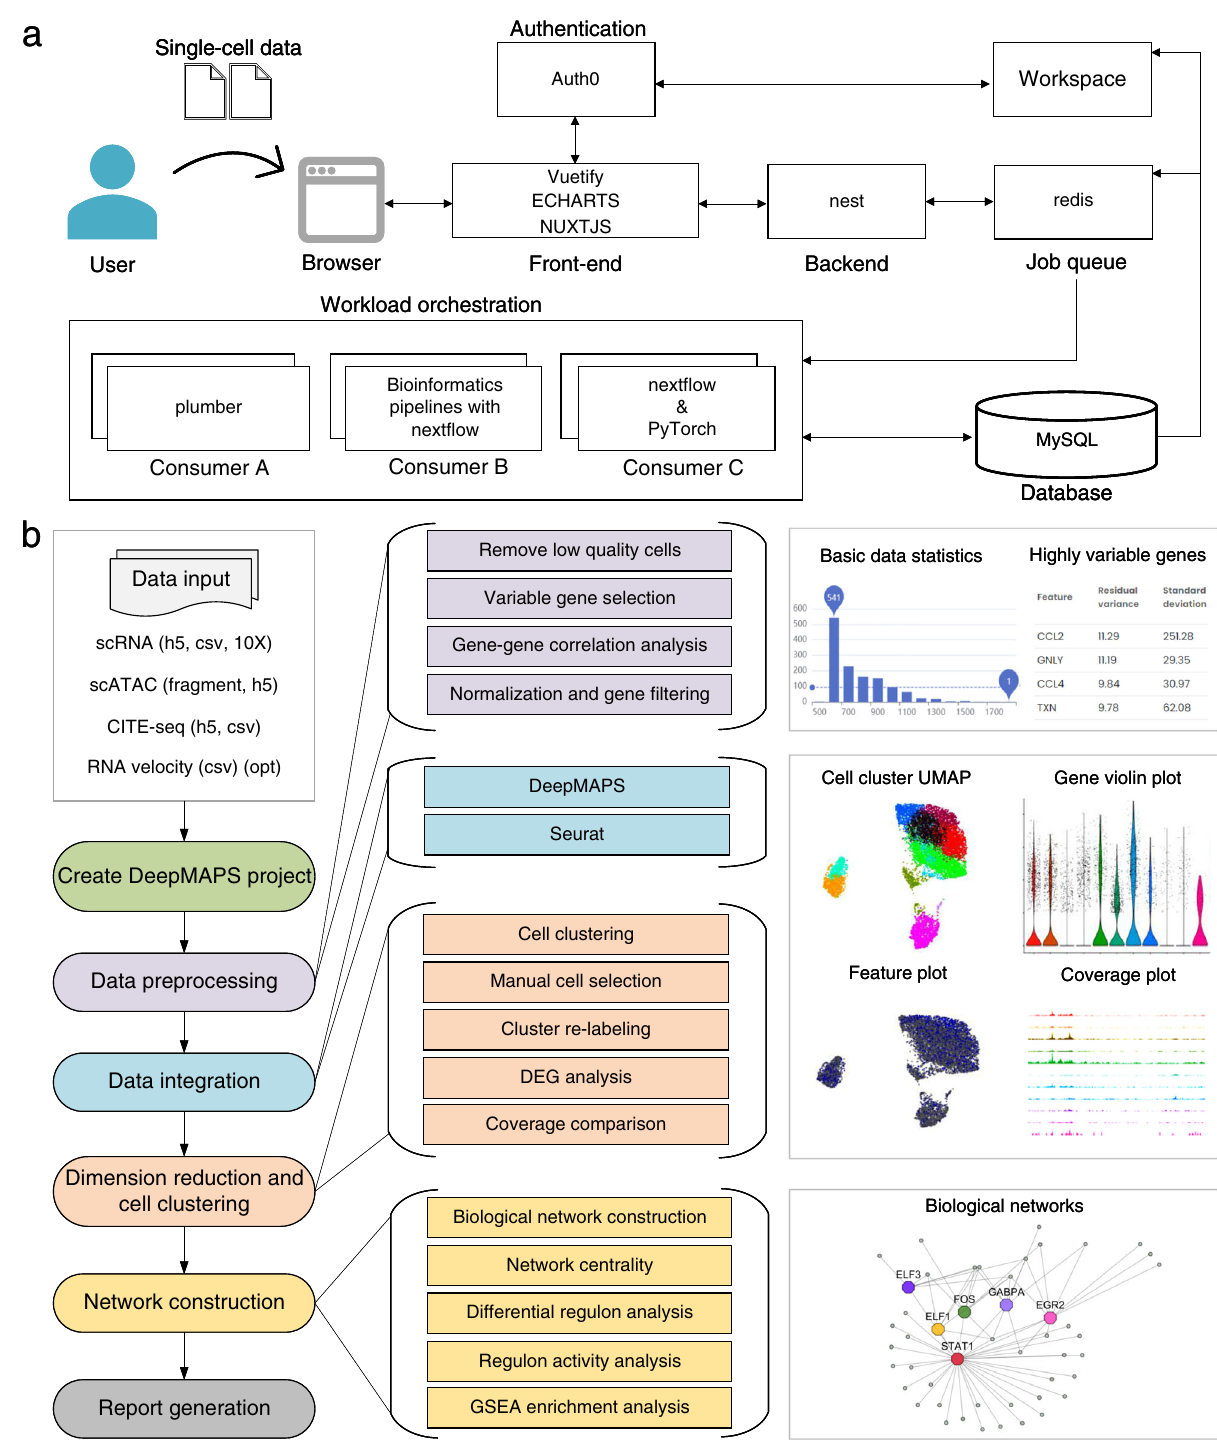
Fig. 6 | The organization of the DeepMAPS web portal. a Software-engineering diagram of DeepMAPS and an overview of the framework. b Pipeline illustration of the server, including major steps (left; colors indicate different steps), detailed analyses (middle), and featured fi gures and tables